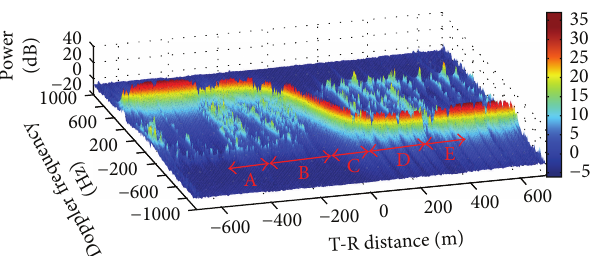
Doppler frequency shift of multipath components. Doppler frequency shift is associated with the angle of arrival (AOA) between the multipath wave and direction of motion. Since multipath components with different AOAs have different Doppler frequency shifts, this causes a spreading of the received signal in the frequency domain. Doppler